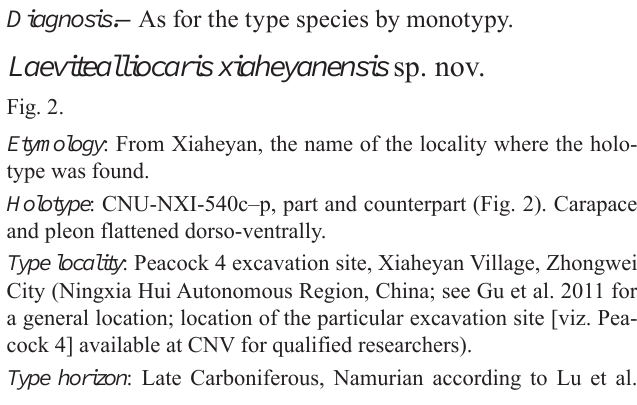
, B ), RTI high-resolution views, bookmarked in the RTI file available in SOM (RTI model by PG 1 1